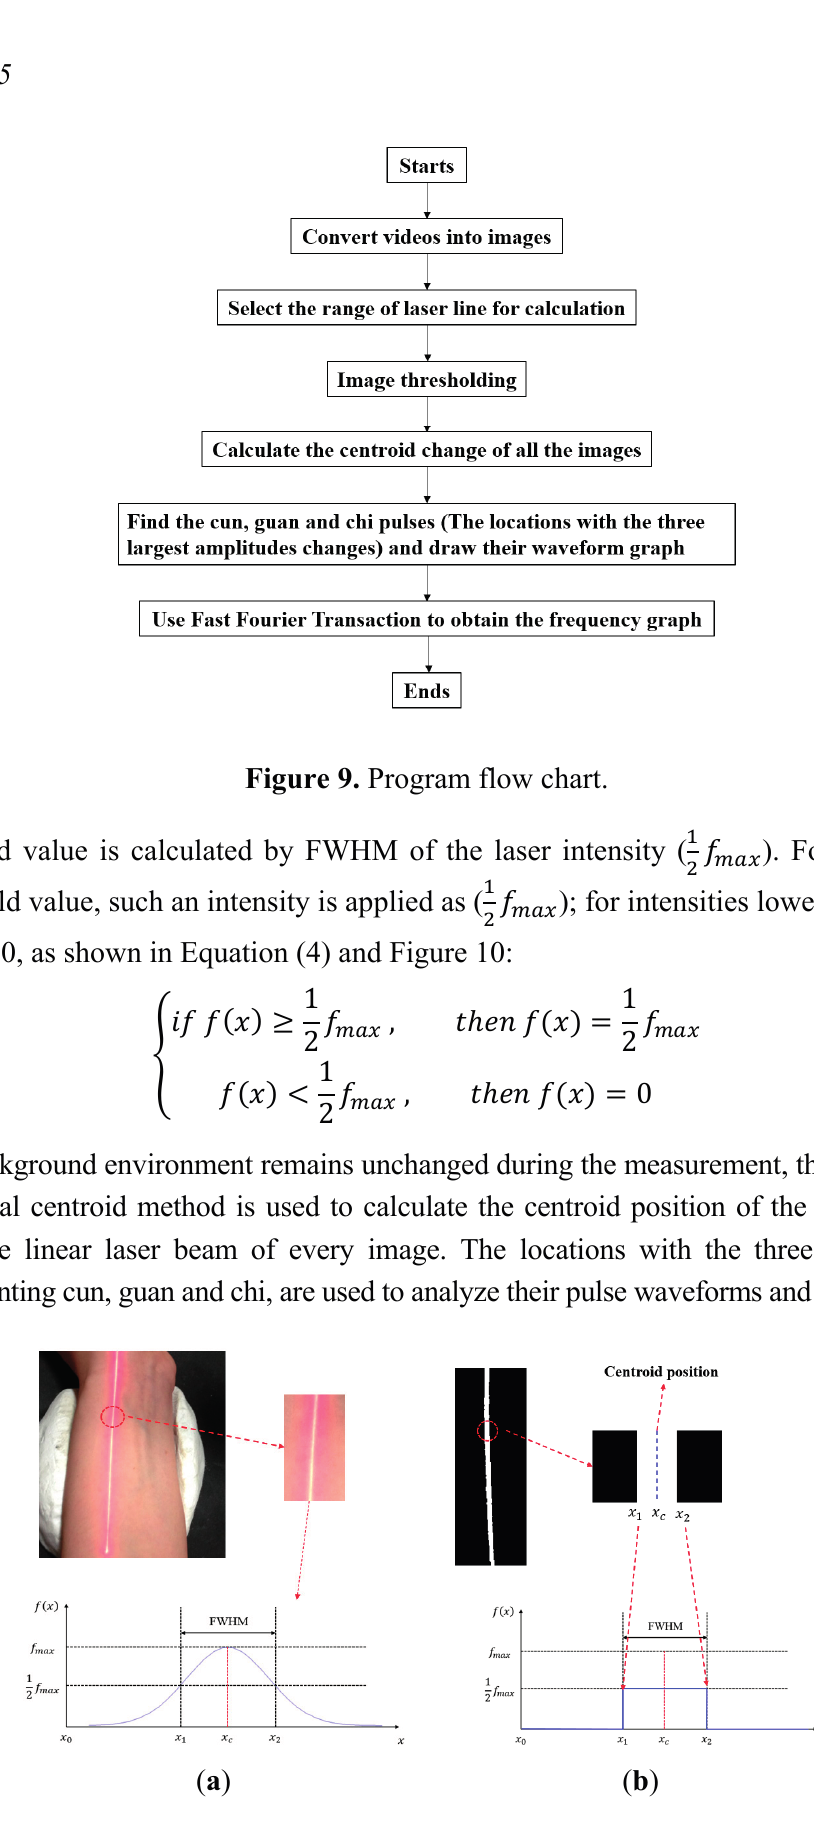
Figure 10. The image and distribution of laser intensity. ( a ) before thresholding; ( b ) after